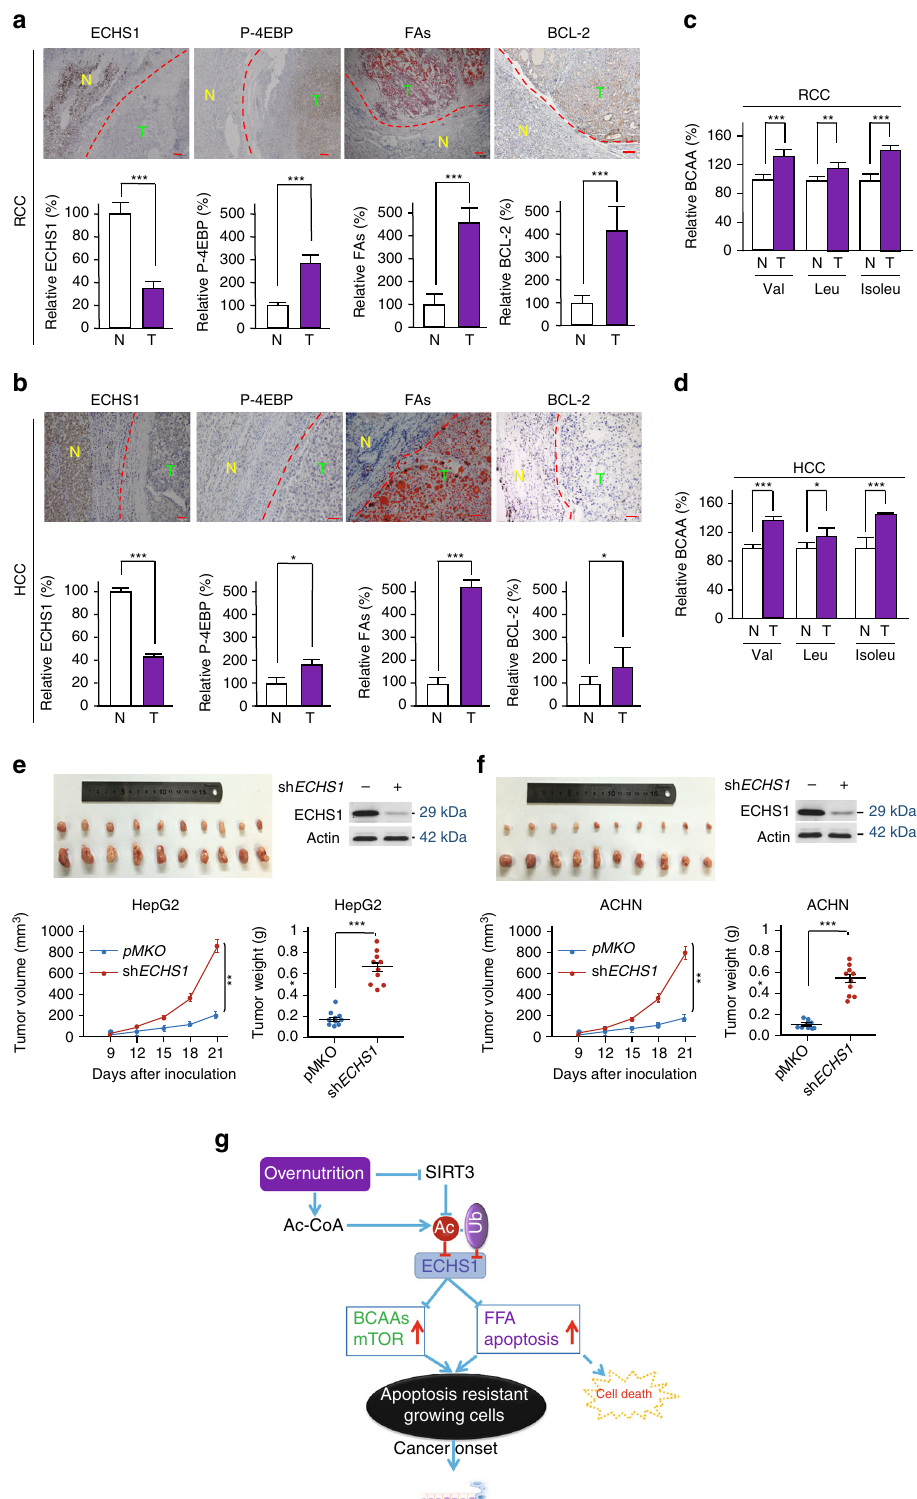
Fig. 10 ECHS1 downregulation promotes BCAA and FA accumulation and cancer growth. a , b IHC analysis for ECHS1, P-4EBP, FAs, and BCL-2 in RCC ( a , scale bars : 200 μ m) and HCC ( b , scale bars : 50 μ m) specimens and their respective adjacent normal tissues. c , d Relative levels of BCAAs were determined in RCC ( c ) and HCC ( d ) tissues and their respective adjacent normal tissues. The levels of BCAAs in normal tissues were set as 100%. e , f The xenograft tumor growth of HepG2, ECHS1 knockdown HepG2, ACHN and ECHS1 knockdown ACHN cells were analyzed in Balb/c nude mice (4 – 6 weeks old). g Schematic diagram indicating how rich nutrients enrich ECHS1-inactivated cells and promote cancer initiation. Nutrients inactivate ECHS1 cause accumulation of BCAAs and FFAs, which induce mTOR activation and lipoapoptosis, respectively. The latter resulted in selection for apoptosis resistant cells and facilitate cancer transformation. Mean values with SD are reported. * P < 0.05; ** P < 0.01; *** P <